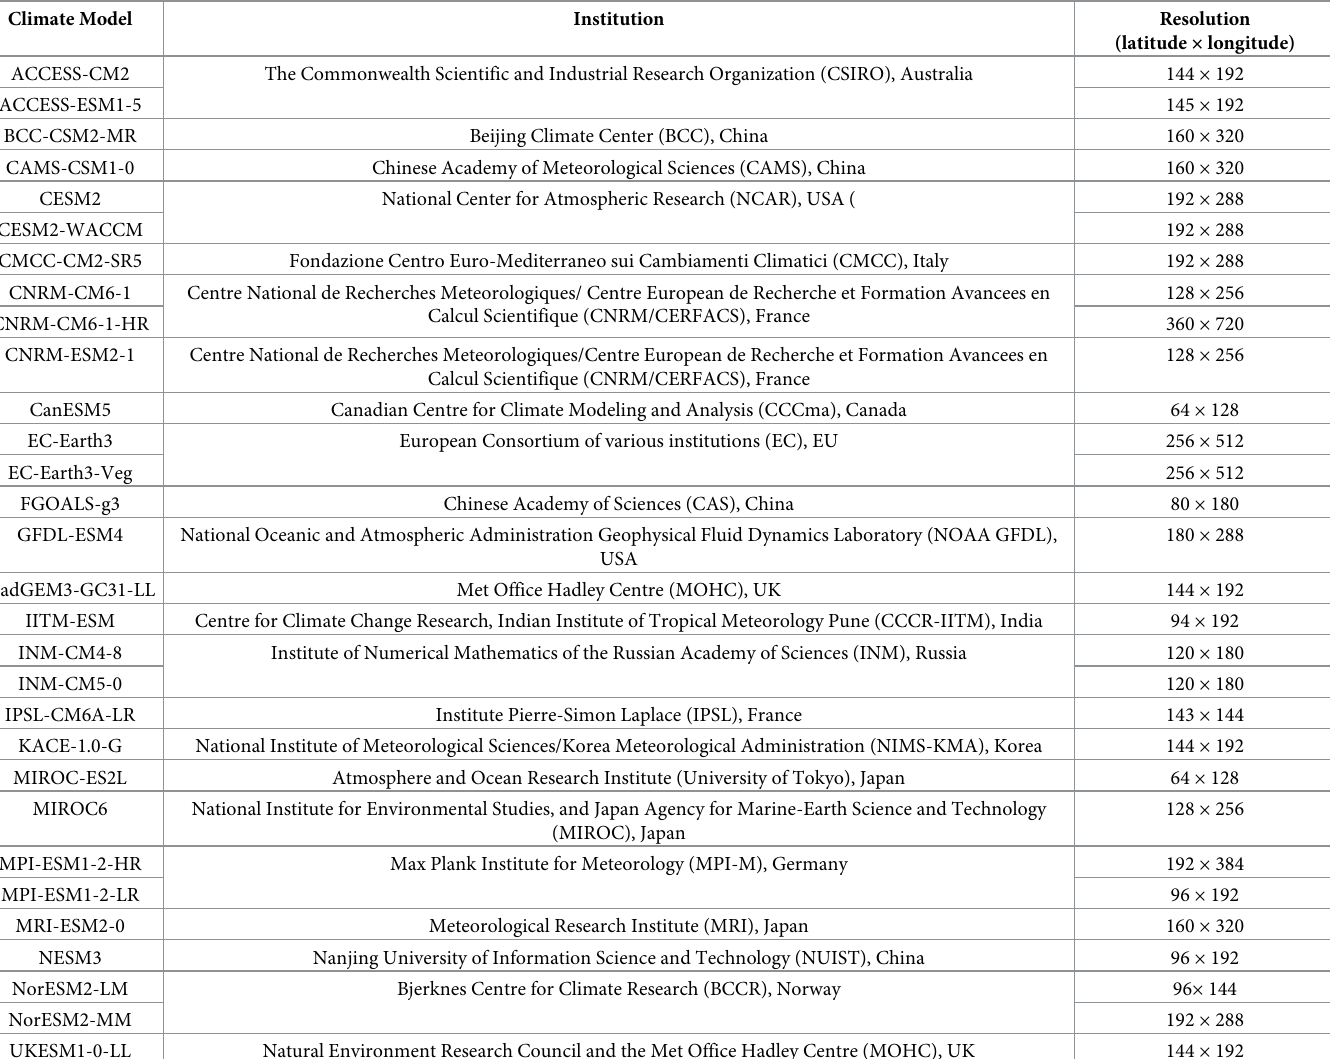
Table 1. Description of the Coupled Model Intercomparison Project Phase 6 (CMIP6) climate models used in this